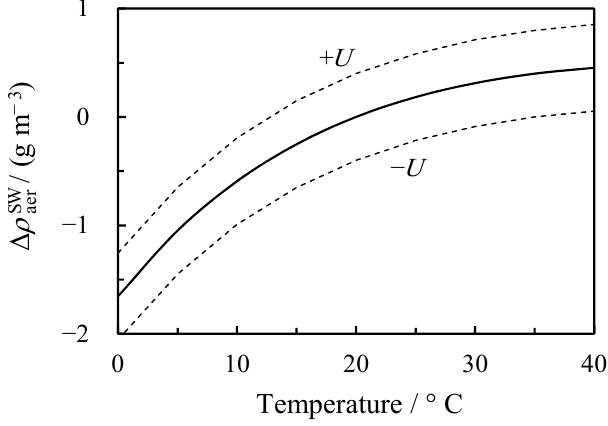
Figure 4. Density correction due to air saturation correction based on 100% saturation at 20 ◦ C. U – estimated